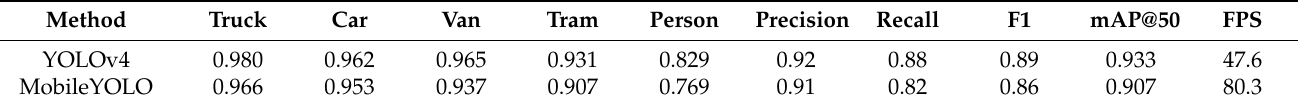
Table 2. The experimental results of YOLOv4 and